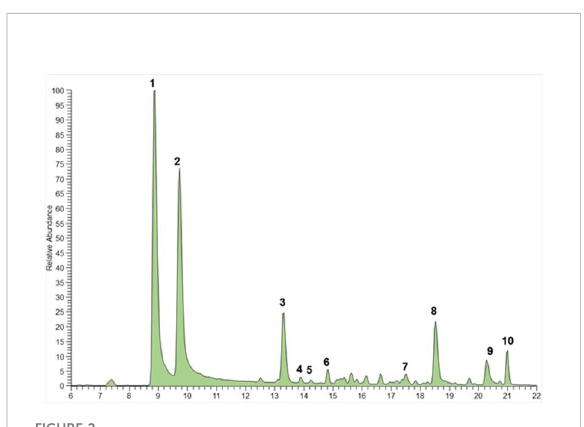
FIGURE 2 UHPLC-HR-ESI- Orbitrap/MS chromatogram (positive ionization mode) of ( B ) bituminosa chloroform extract wild plant. Peak data are shown in Table 7.